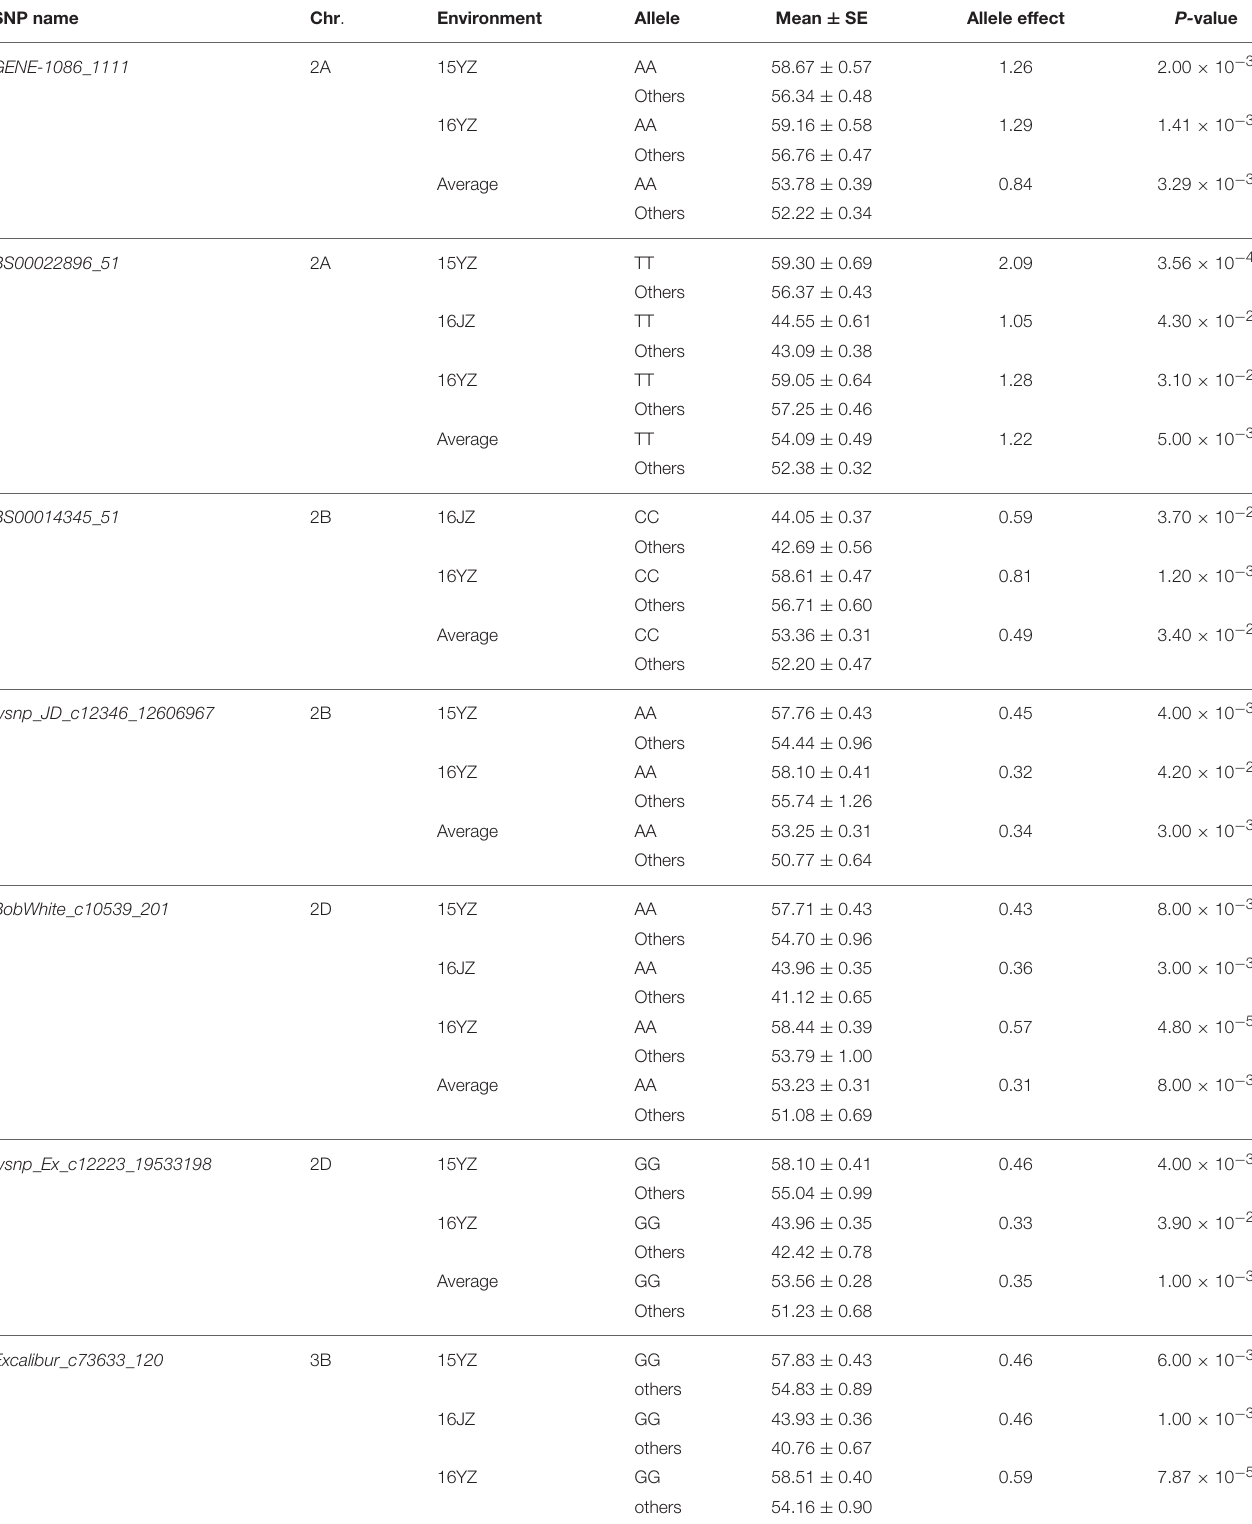
TABLE 4 | Favorable alleles and effects of 12 SNP loci validated in the RIL